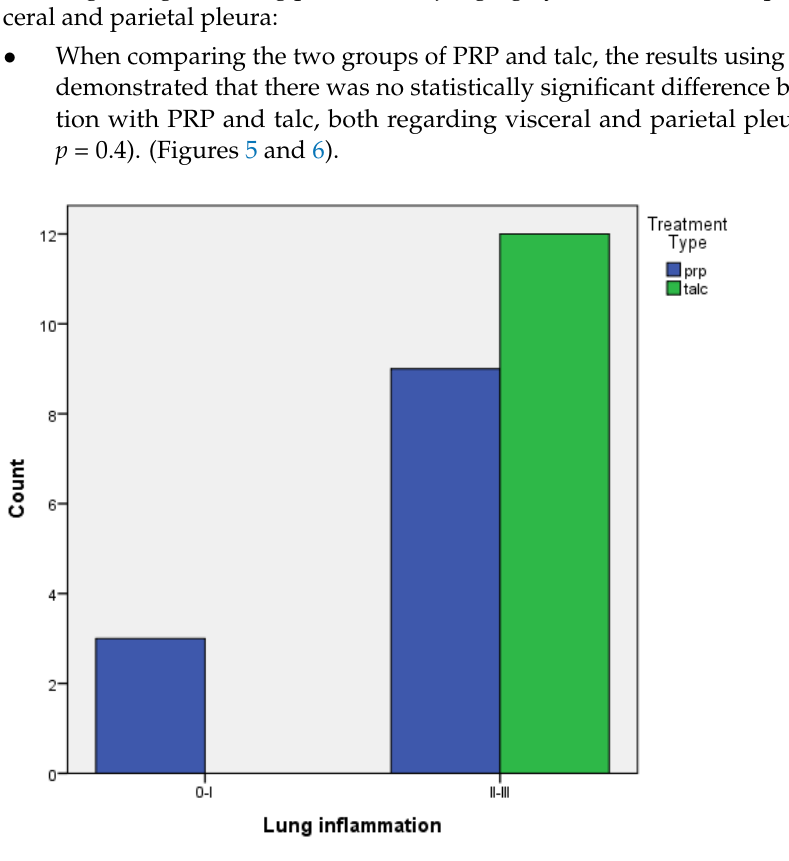
Figure 6. Parietal pleura inflammation of PRP vs. talc. •